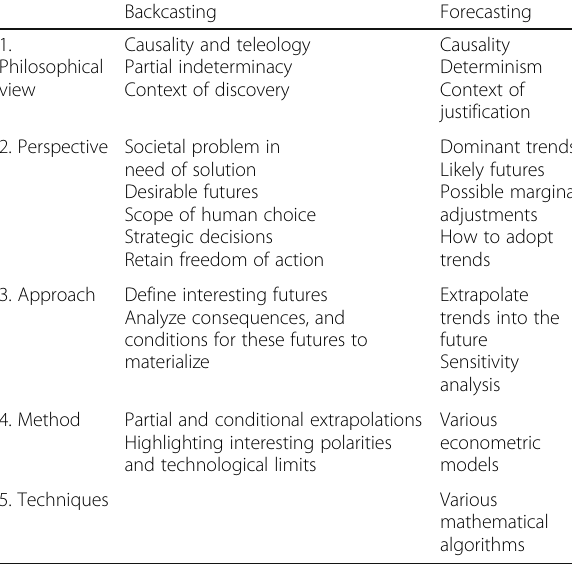
Table 1 Backcasting and forecasting five